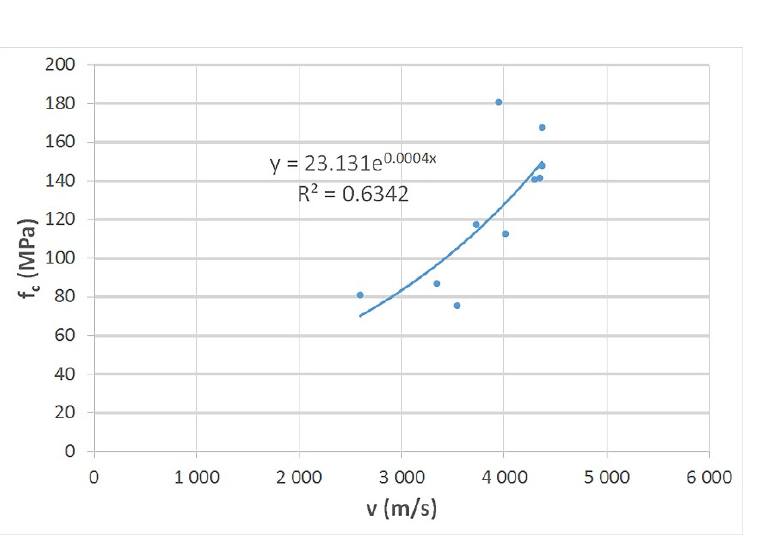
Figure 11. Exponential correlation between cylindric compression strength and ultrasonic speed.